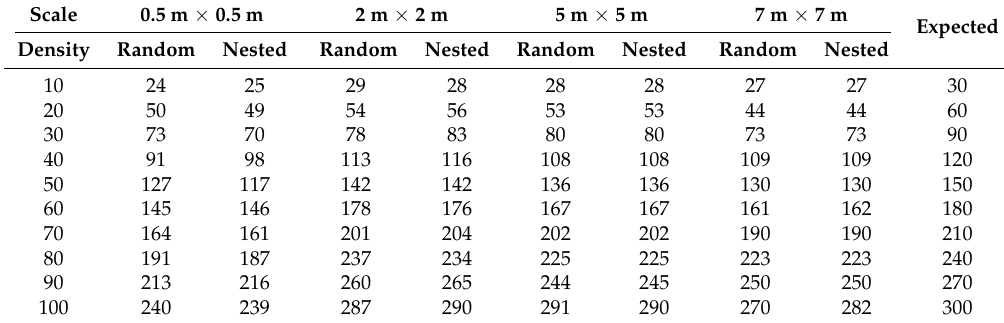
Table 3. Sample size per combination of sampling scale, quadrat density and strategy considered, after exclusion of non-valid samples (i.e., quadrats with more than 40% of the area falling outside the coral reef boundary or presenting non-textured morphological class).